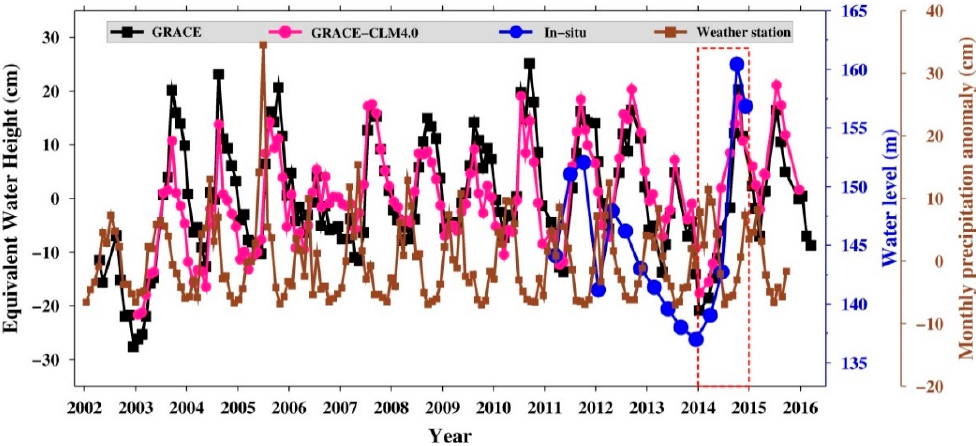
Figure 7. Comparison of the changes in water storage, precipitation, and water level.